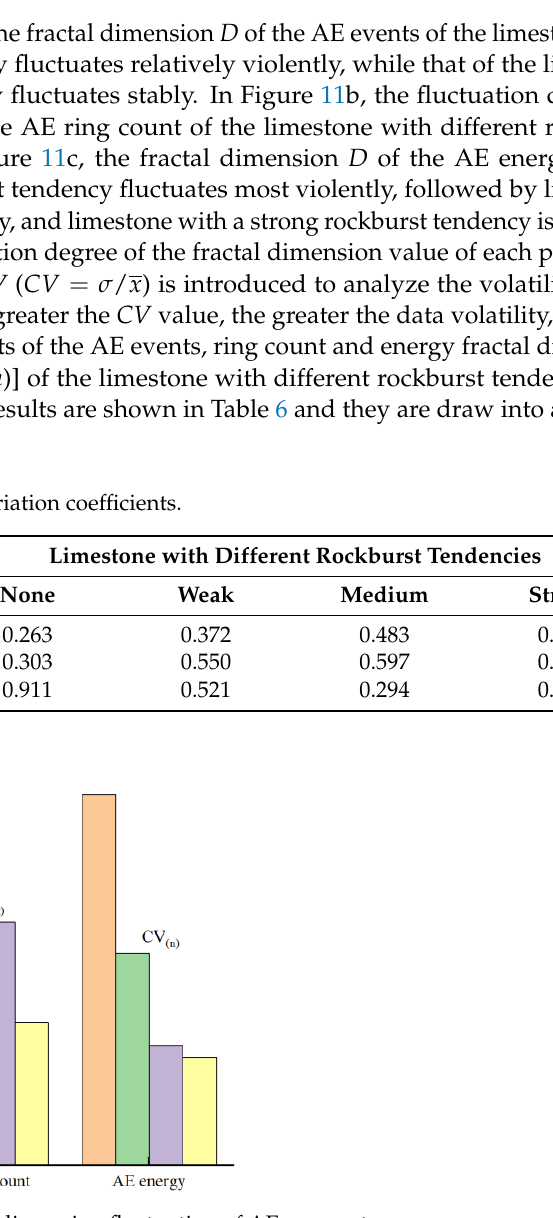
Figure 12. Comparison of fractal dimension fluctuation of AE parameters.